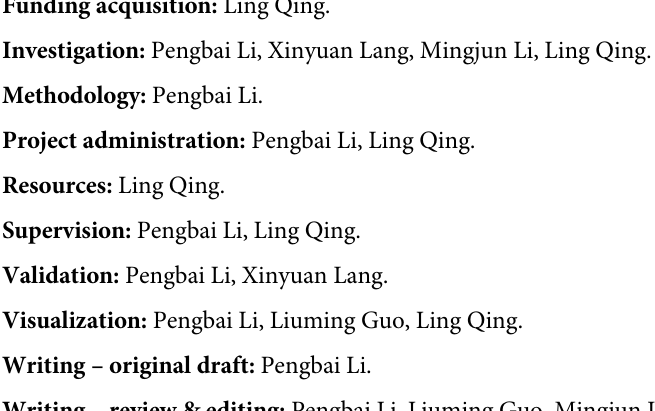
S1 Table. Sequence of primers used in this study. S2 Table. Statistics to support this